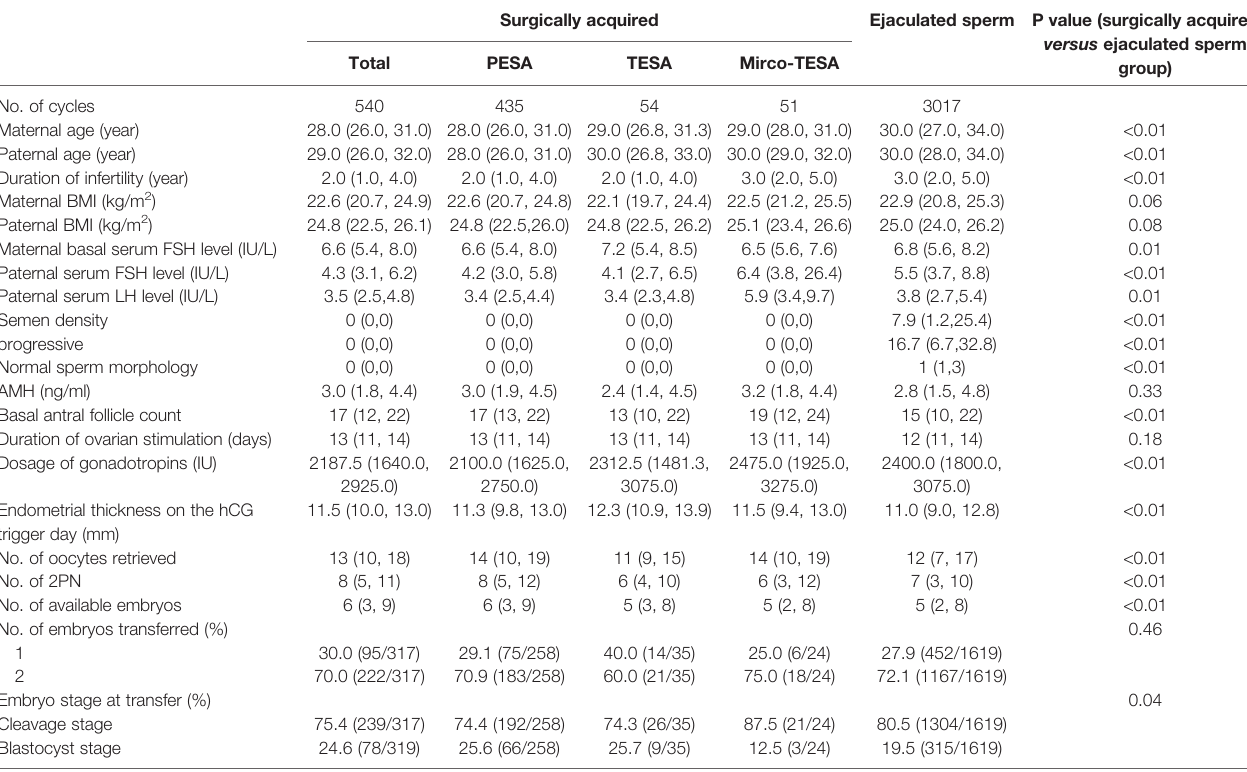
TABLE 1 | Baseline and cycle characteristics among groups.